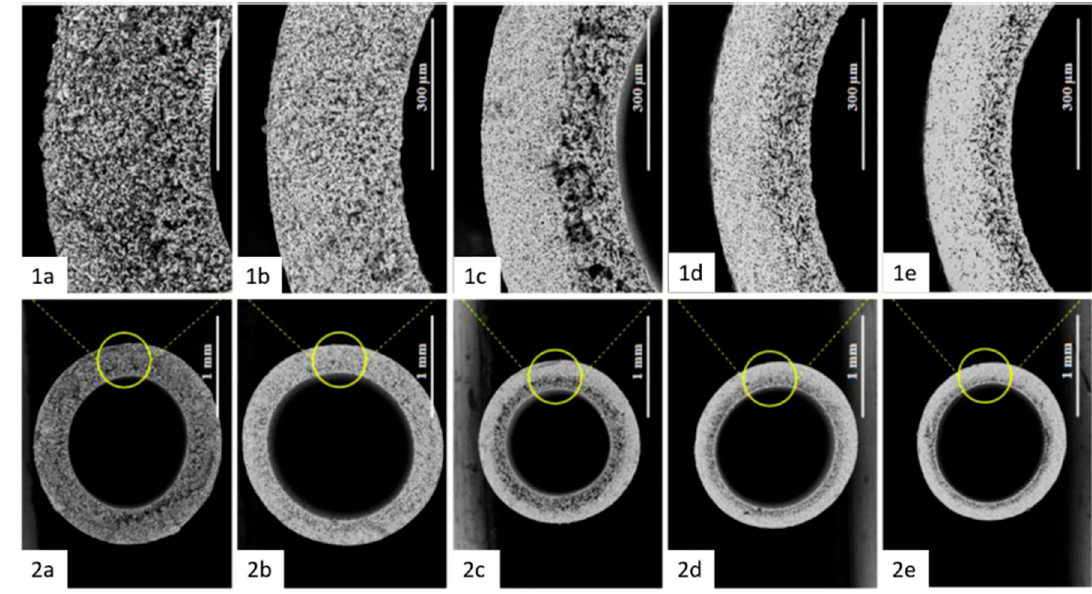
Figure 2. Hollow fiber membranes fabricated using kaolin at different sintering temperatures (( a – e ) at room temperature, 1200 °C, 1300 °C, 1400 °C, and 1500 °C, respectively. 1a-1e enlarged cross section, 2a-2e normal cross section). At room temperature, hollow fibers have sponge-like pores; however, sintering at 1200 °C leads to densification by grain growth, and further increasing temperature leads to more densified membranes with smaller pores (adapted from ref. [22] with permission from Springer Nature).